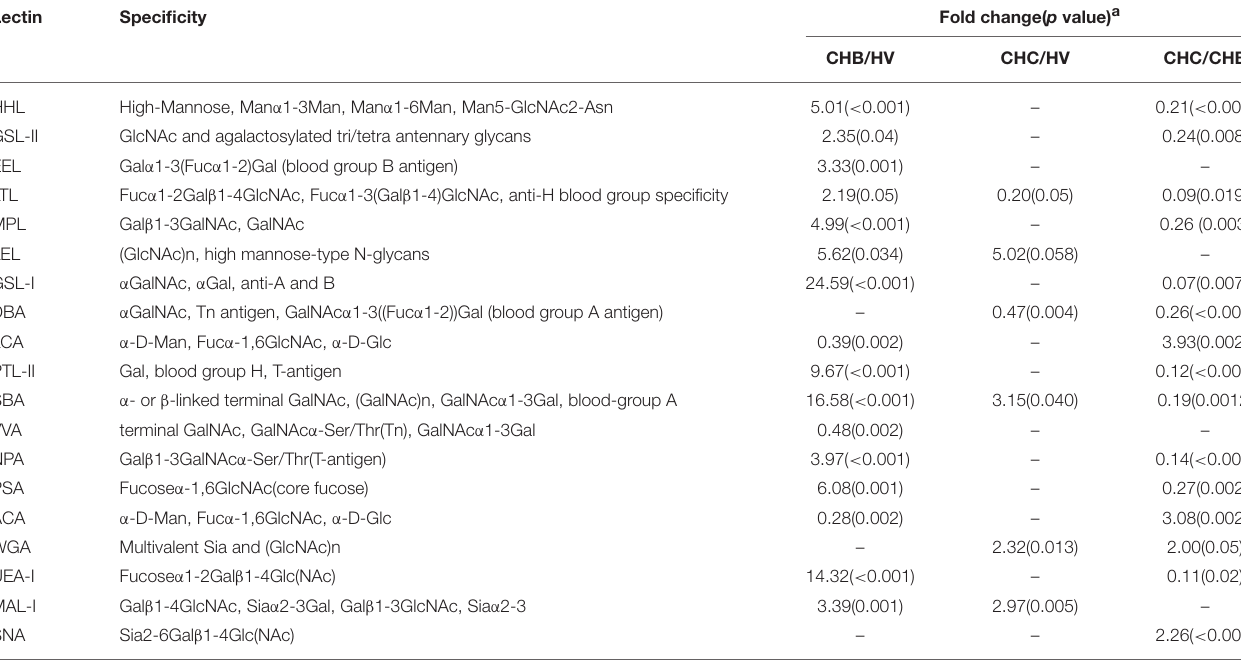
TABLE 2 | Fold change of the pooled protein glycopatterns in sera from patients with CHB or CHC, and healthy volunteers (HV) based upon ratio of the NFIs of each lectin.